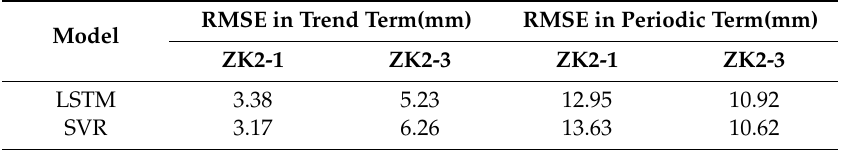
Table 6. Accuracy of the prediction in trend term and periodic term of ZK2-1 and ZK2-3. Model